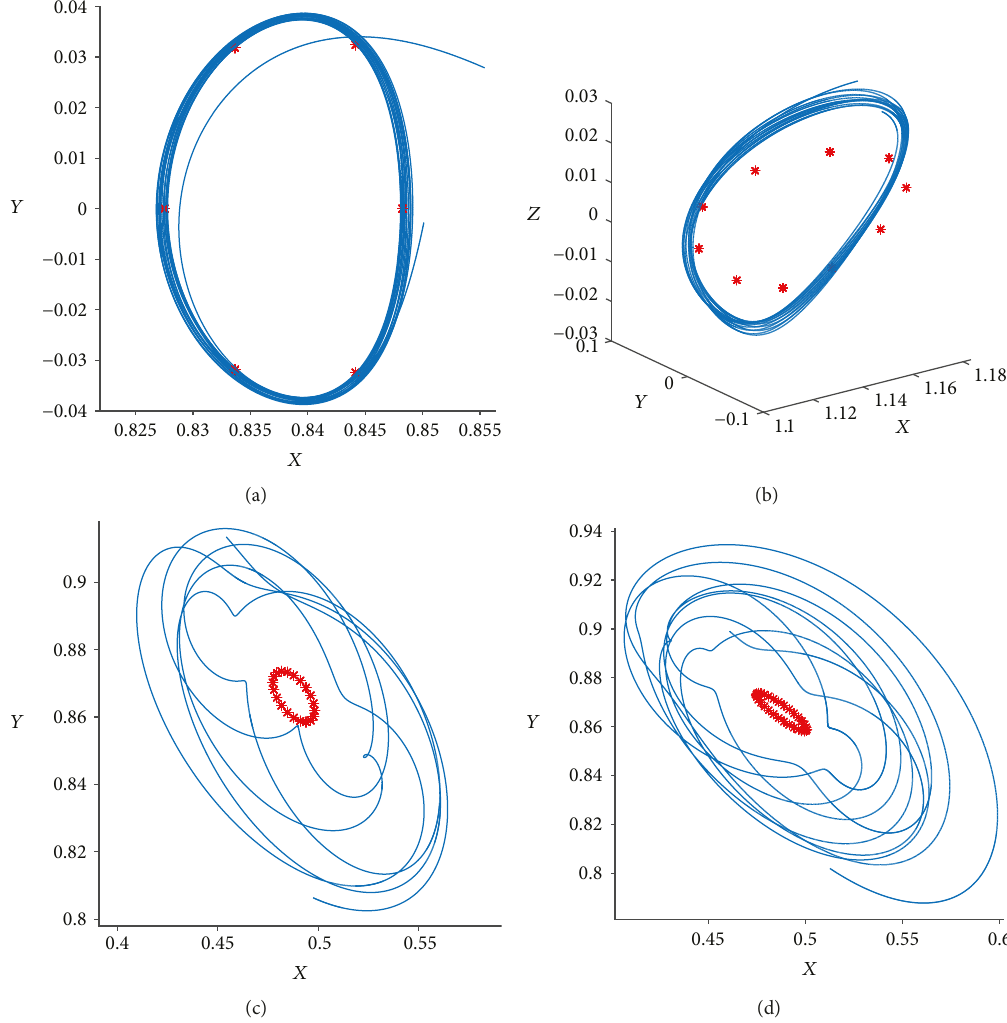
Figure 2: Reconverged orbits and their original patch points: (a) L ( amplitude = 8,000km ); (c) L